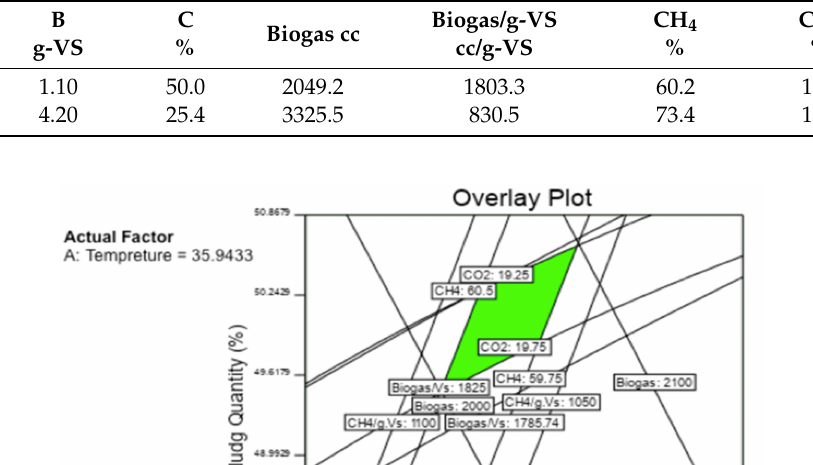
Table 15. The optimal results of the two criterions for date seed.